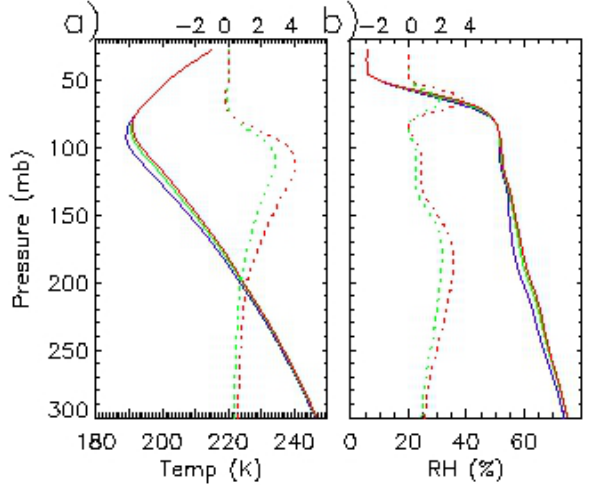
Fig. 15. As in Fig. 13, except for ensemble-average profiles of (a) temperature and (b) relative humidity, for PRIS (blue), POLL (green), and SPOLL (red). Also shown are differences between POLL and PRIS (green dotted line) and SPOLL and PRIS (red dot- ted line), with values shown on the axis at the top of the plots.